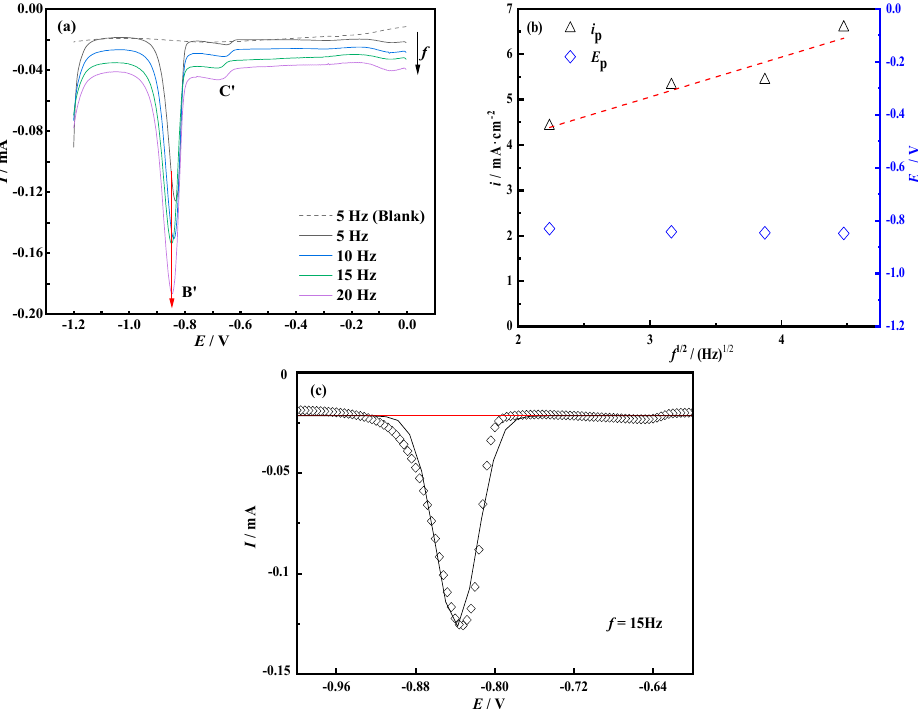
Figure 4. ( a ) Square wave volt-ampere curves under different scanning frequencies; ( b ) I–f 1/2 relationship diagram of peak B (cid:48) ; ( c ) peak shape fitting graph of 15 Hz peak B (cid:48) ( T = 30 ◦ C). In the formula: R-molar gas constant (8.3145 J/mol/K); n -electron transfer number; T -temperature (K); F-Faraday’s constant (96,485